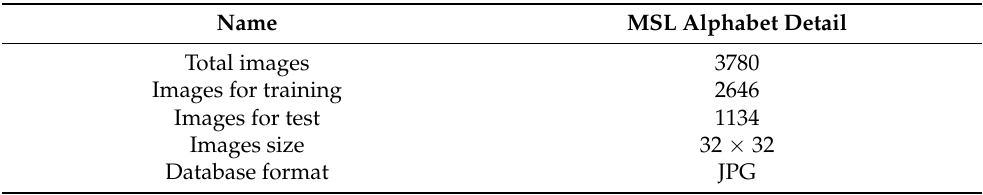
Table 7. MSL alphabet database description.